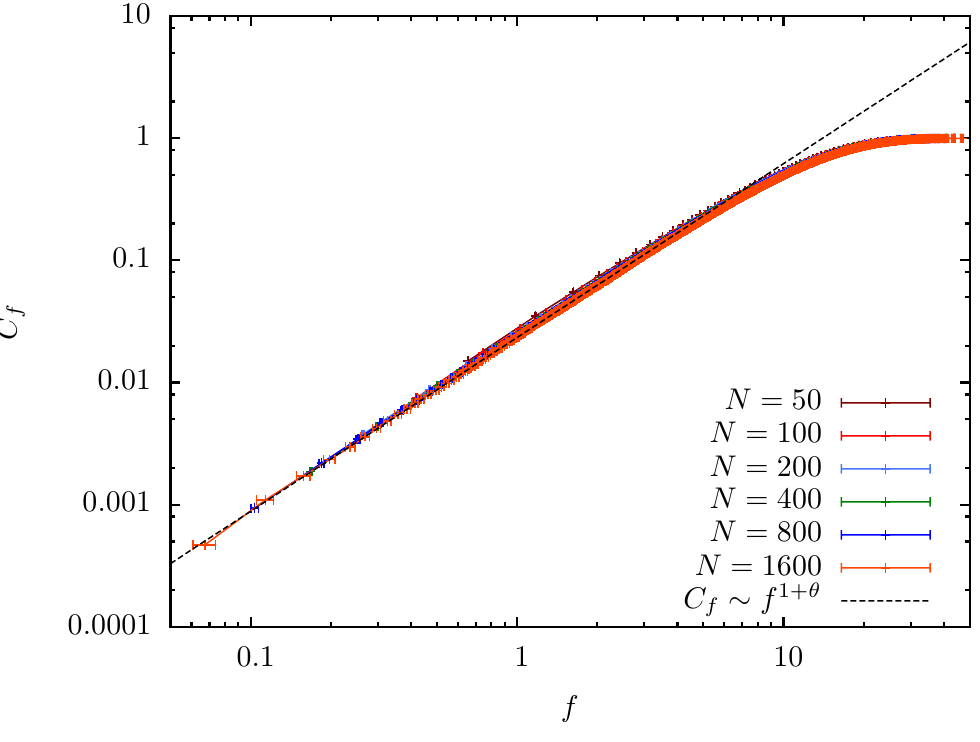
= (cid:82) f d ˜ f p ( ˜ f ) for N = 50,...1600. f 0 ∼ f 1 + θ f